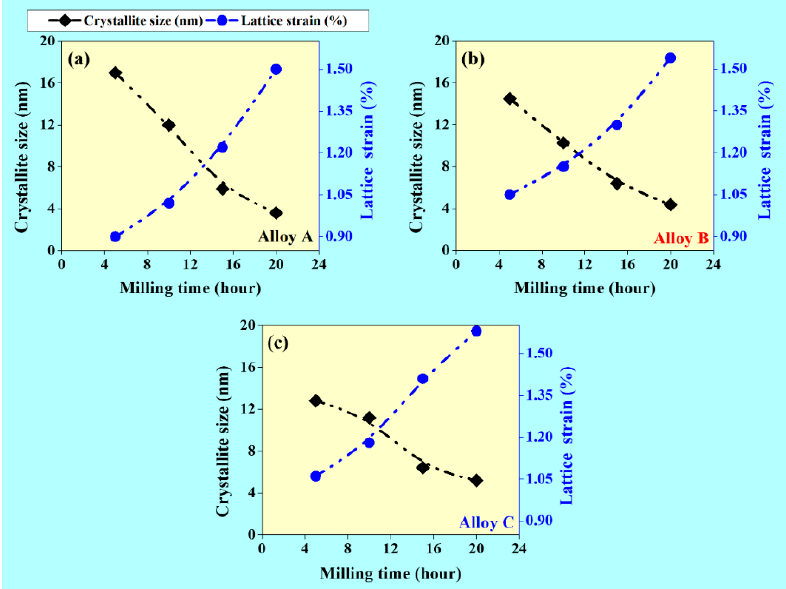
Figure 2. Crystallite size and lattice strain of the mechanically alloyed powders for the alloys ( a ) A, ( b ) B, and ( c ) C calculated from the XRD patterns as a function of milling time.